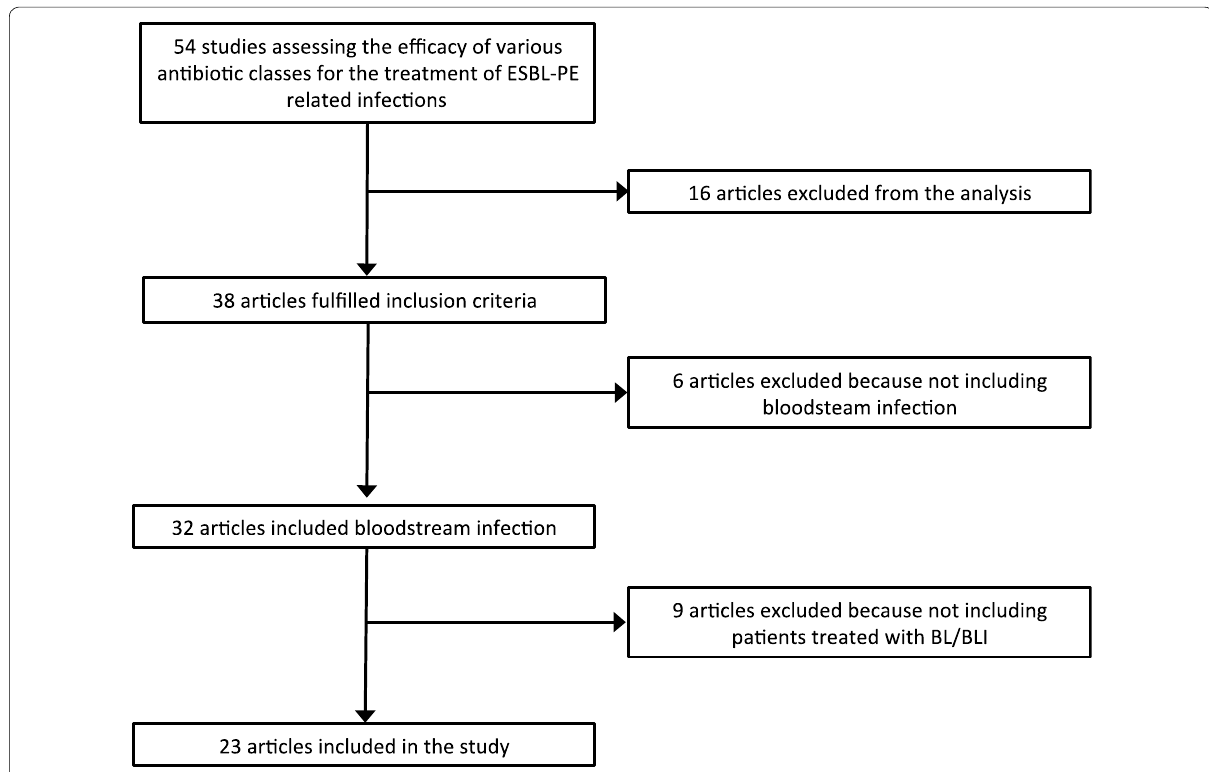
Fig. 1 Flow diagram of the selection process of the included